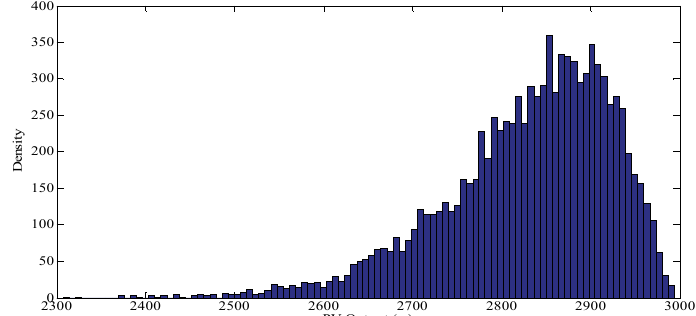
Figure 10. The PDF of PV generation.